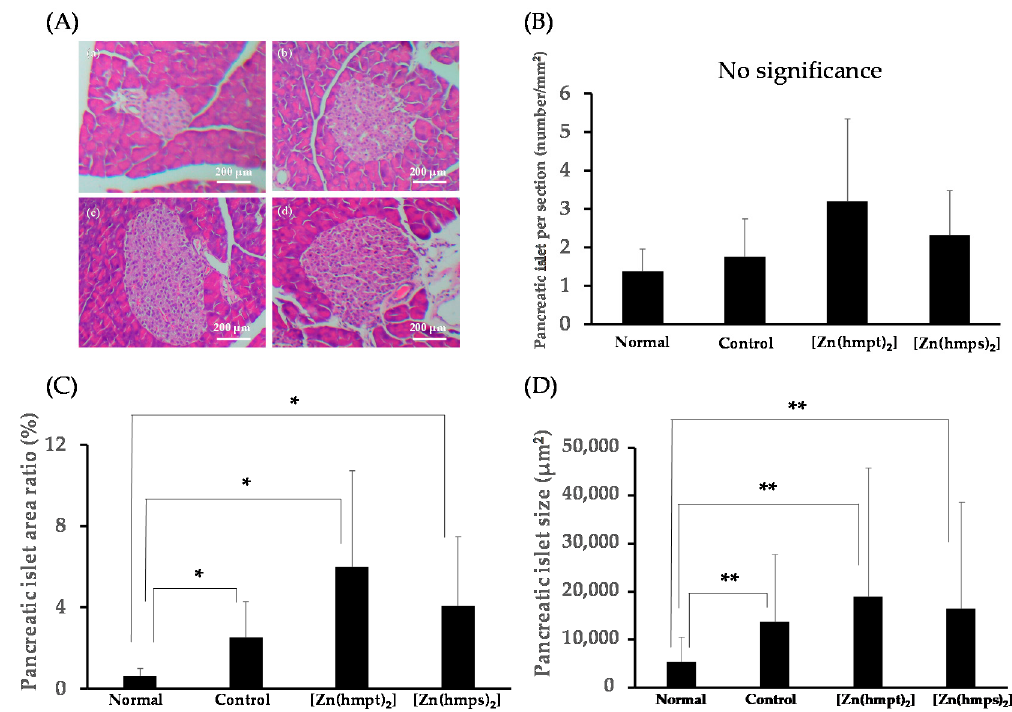
Figure 5. ( A ) Pancreatic morphology in 14-week-old ( a ) normal; ( b ) control (PEG-400 administered); ( c ) [Zn(hmpt) 2 ]-treated; and ( d ) [Zn(hmps) 2 ]-treated mice. Hematoxylin and eosin staining, ×100 (scale bar = 200 μ m); ( B ) Pancreatic islet per section (number/mm 2 ) (normal mice: n = 57, control mice: n = 72, [Zn(hmpt) 2 ]-treated mice: n = 92, [Zn(hmps) 2 ]-treated mice: n = 183 pancreatic islets); ( C ) Pancreatic islet area ratio (%); ( D ) Pancreatic islet size ( μ m 2 ). Data are expressed as the means ± SDs for 6–8 mice. Statistical analysis was performed using the Steel-Dwass test; significance: * p < 0.05 and ** p < 0.01 vs. normal mice.